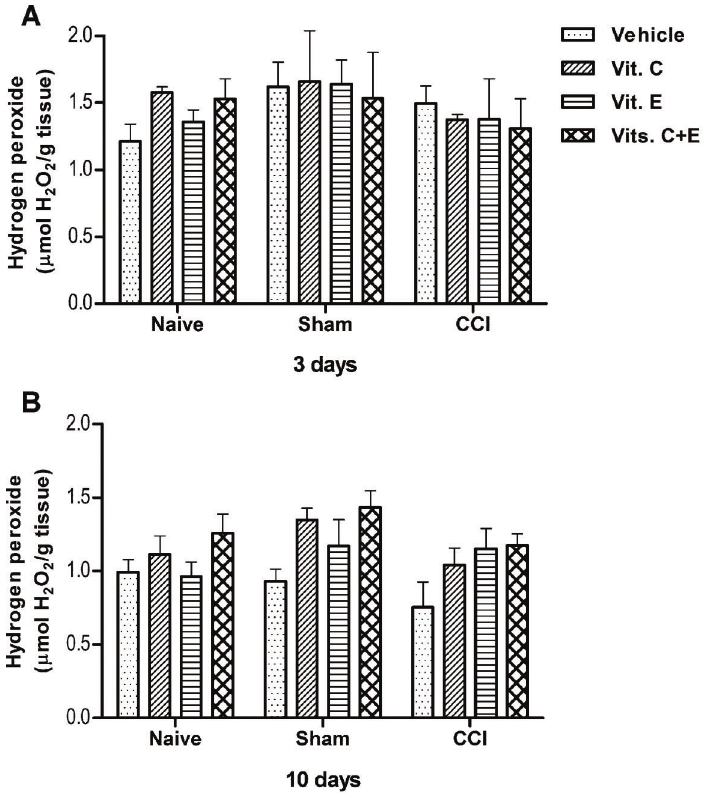
Figure 5. Hydrogen peroxide levels in the spinal cord of rats treated with vit. C (30 mg (cid:1) kg – 1 (cid:1) day – 1 ), vit. E (15 mg (cid:1) kg – 1 (cid:1) day – 1 ), a combination of these vitamins (vits. C + E) in the same doses, or the vehicle alone (saline containing 1% Tween 80) administered intraperitoneally for 3 ( A ) and 10 ( B ) days after chronic constriction injury (CCI). Data are reported as means ± SE (n=6/group). No statistical difference between groups was found (two-way ANOVA followed by Tukey post hoc